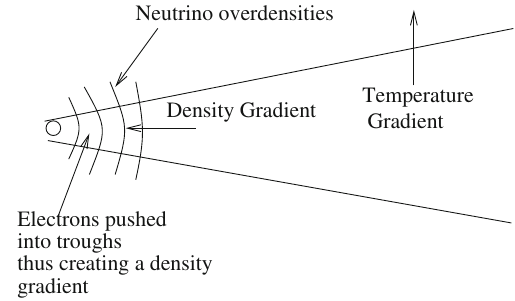
Fig. 2 An illustration to show the generation of magnetic field in the wakes of cosmic strings due to the non uniform neutrino overdensities